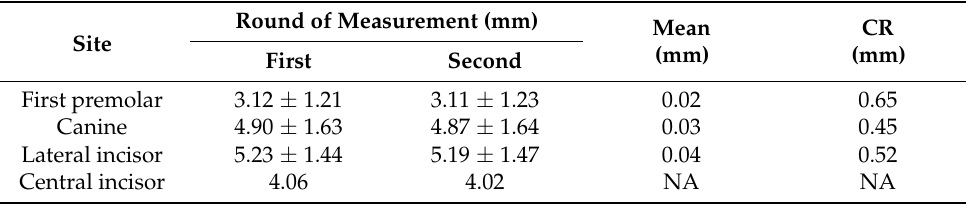
Table 6. Variability in measurement of distance between the MIC and the buccal cortical plate. Round of Measurement (mm) Mean CR Site (mm) (mm)First Second First premolar 3.12 ± 1.21 3.11 ± 1.23 0.02 0.65 Canine 4.90 ± 1.63 4.87 ± 1.64 0.03 0.45 Lateral incisor 5.23 ± 1.44